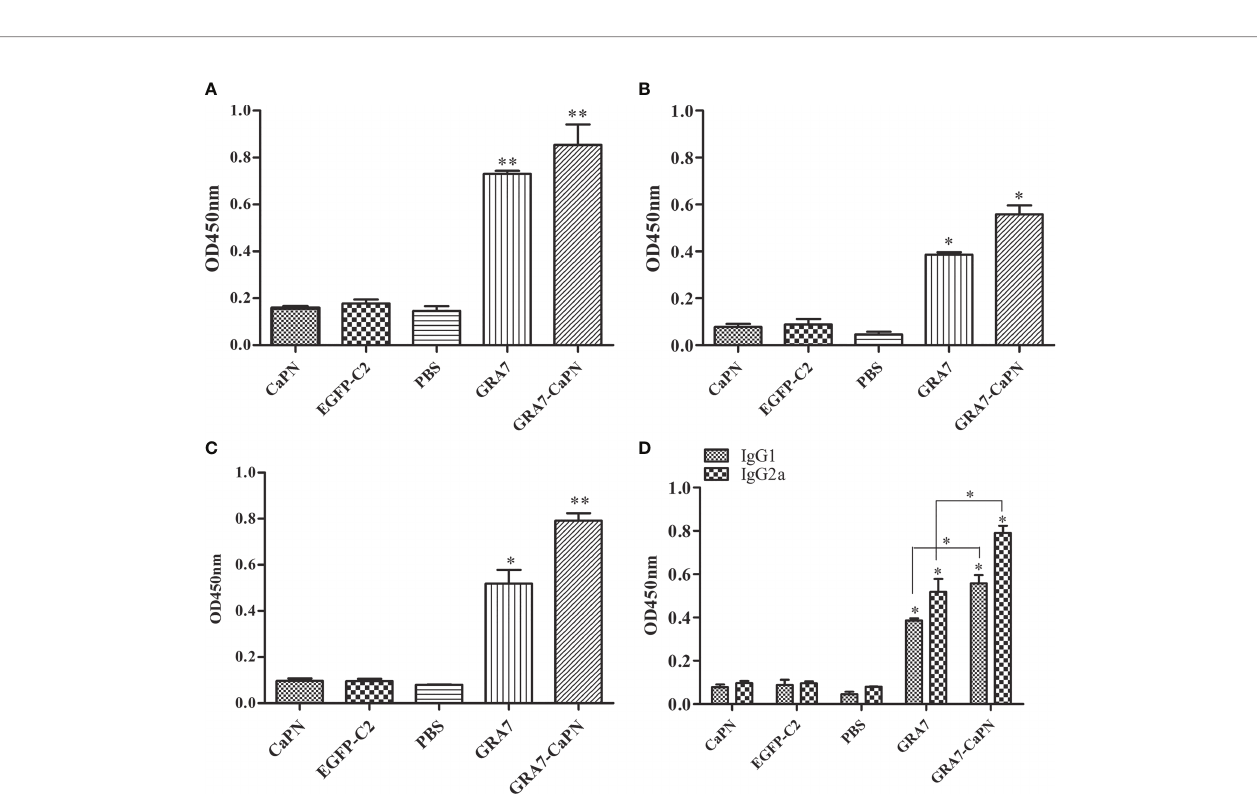
FIGURE 3 | Speci fi c immunoglobulin G (IgG) and IgG isotype analysis. (A) Total IgG. (B) IgG1. (C) IgG2a. (D) Levels of IgG1 and IgG2a. Results are represented as the means of OD 450 nm ± SD. * P < 0.05, ** P < 0.01. The labels “ GRA7 ” and “ GRA7-CaPN ” in Figures 3 – 7 were the abbreviations of “ GRA7- pEGFP-C2 ” and “ GRA7- pEGFP-C2-CaPNs ”